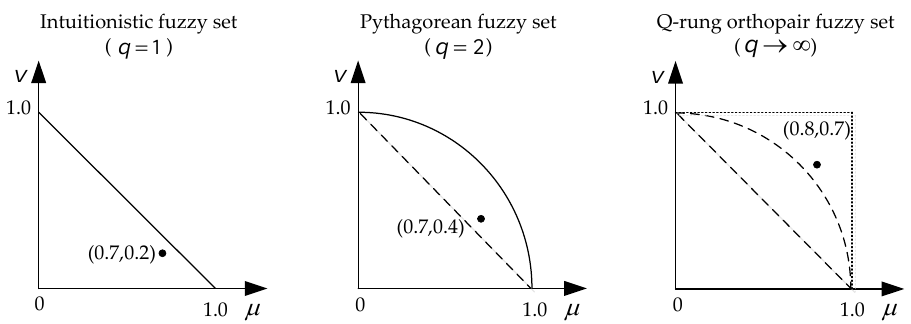
Figure 1. According to the q-ROFS and interval numbers, Wang et al. [23] proposed the q-RIVOFS to construct a new GSS approach; unfortunately, the approach ignored the situations of the large-scale decision makers and the non-consensus evaluation information.